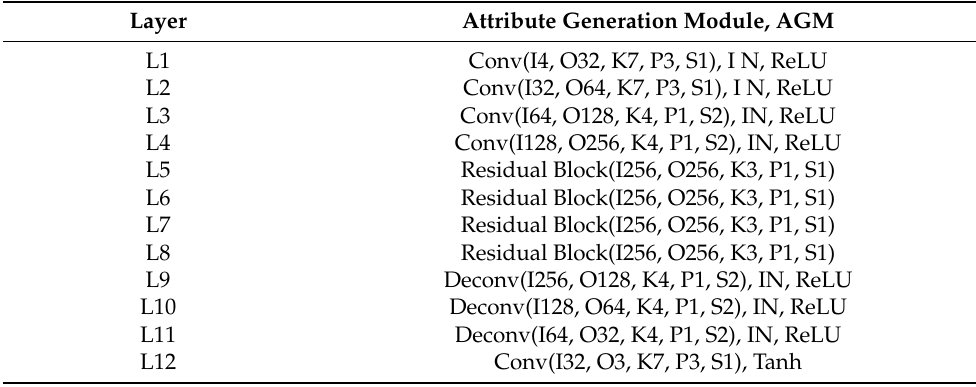
Table 3. Architecture of attribute generation module (AGM).